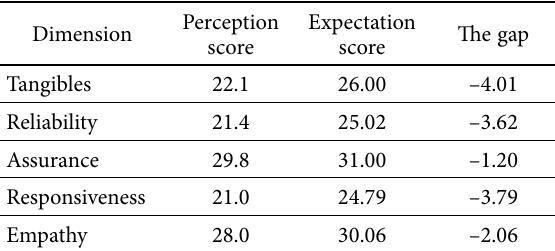
Table 4. The results of research on drivers’ point of view applying the SERQUAL